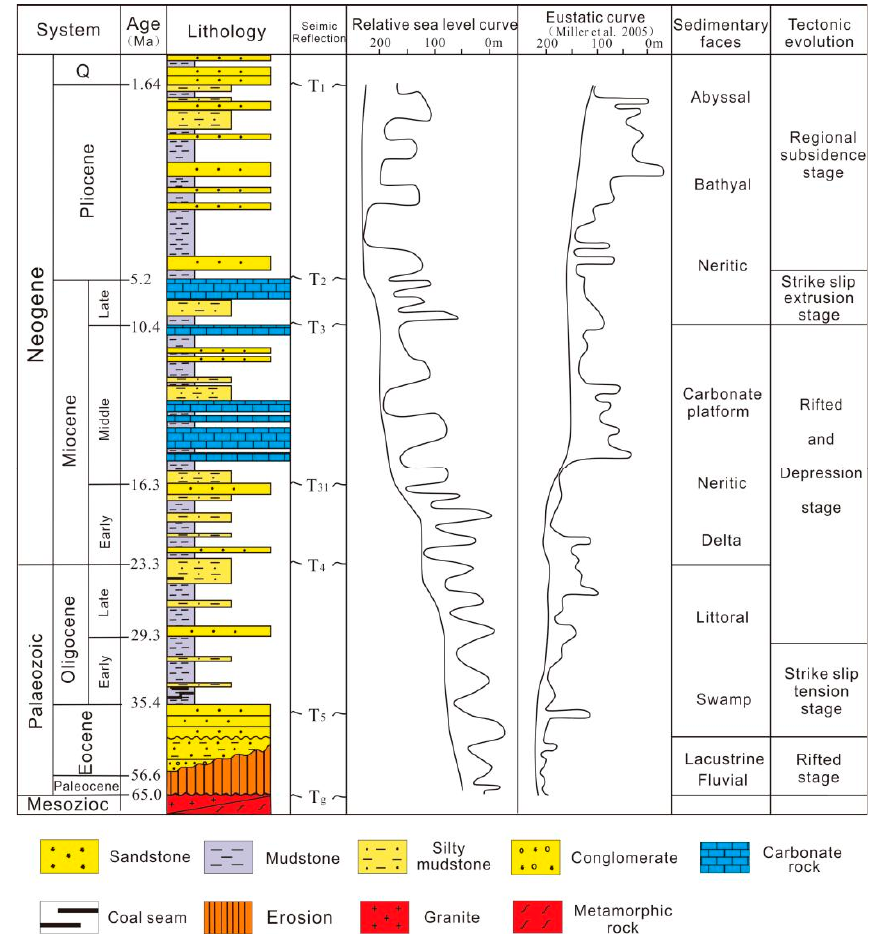
Figure 3. Tectono-stratigraphic scheme for the Wan’an Basin, modified a